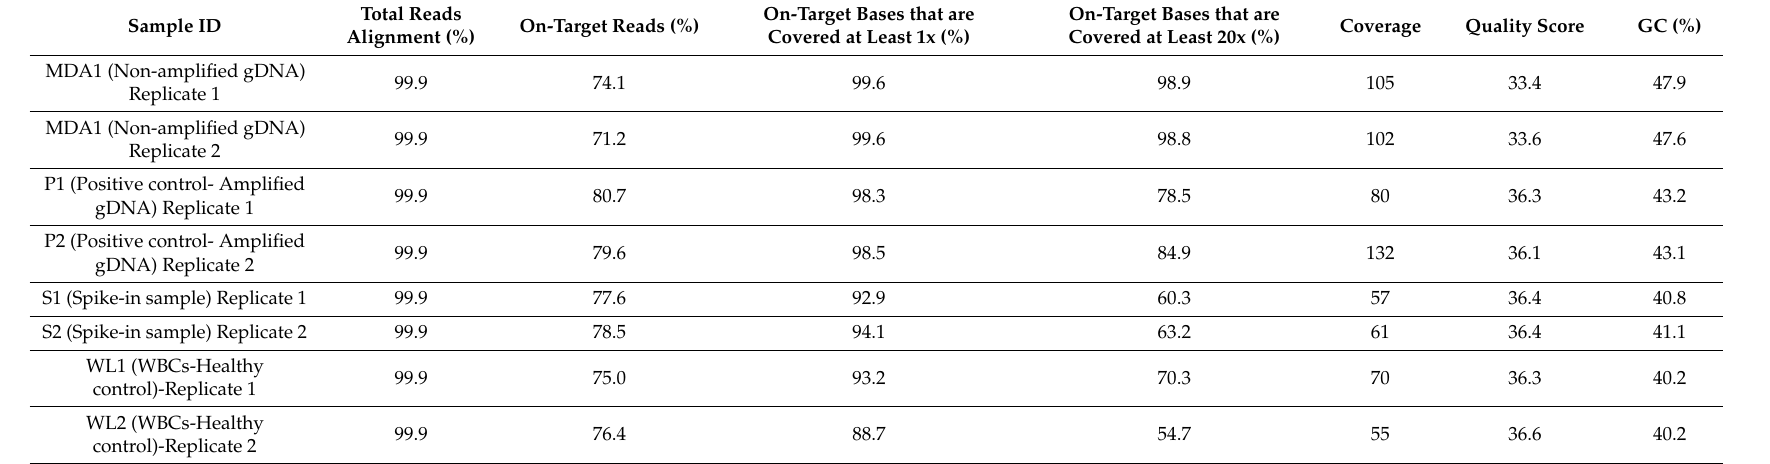
Table 1. Summary of sequencing and alignment statistics across all experimental